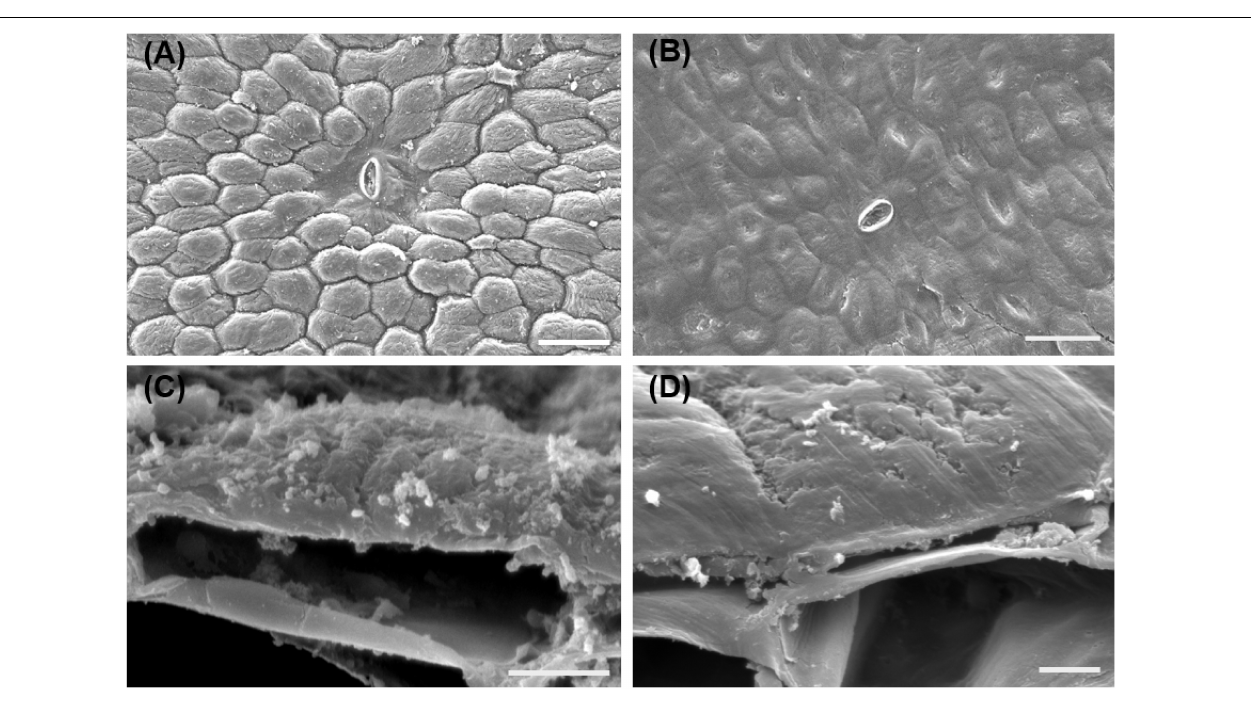
FIGURE 2 | SEM observation of the surface changes of banana fruit during storage. (A,C) Surface microstructure changes sored at 25 ◦ C for 6 days. (B,D) Surface of banana fruit under 4 ◦ C at 6 days. Size bars: (A,B) 50 ¸tm and (C,D) 5